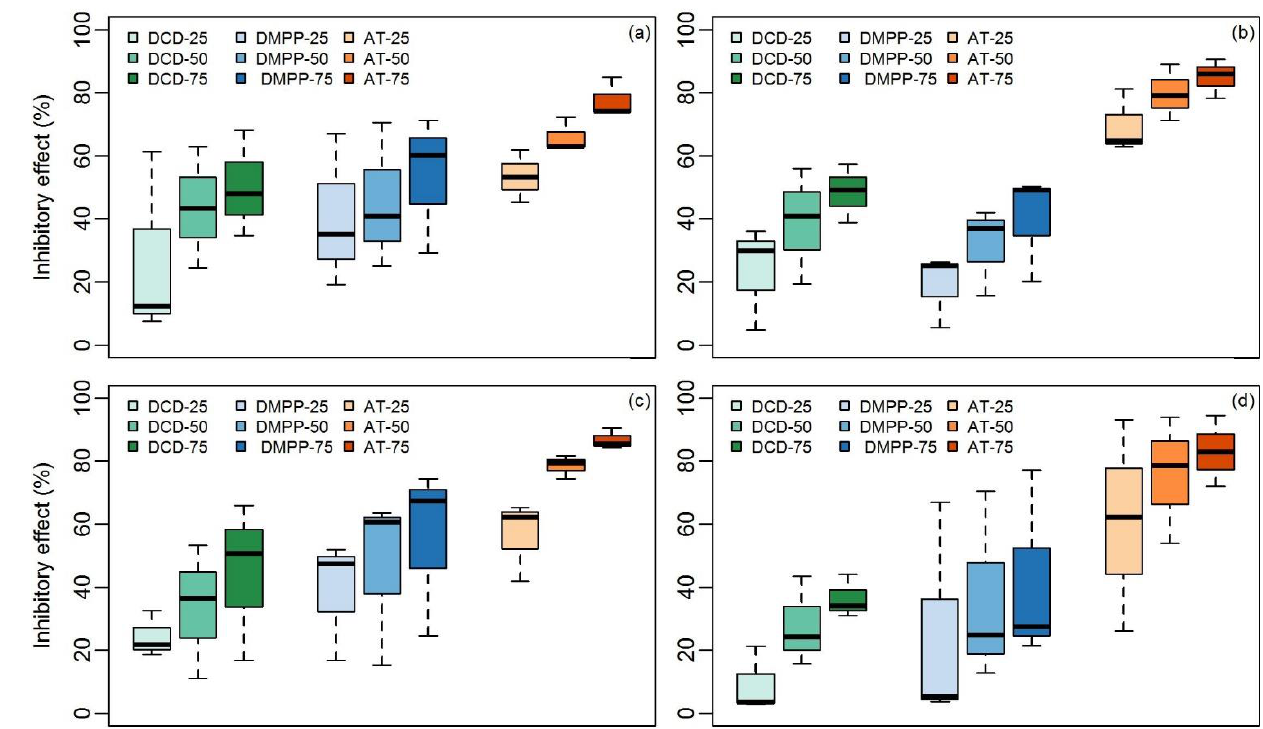
Figure 3. Boxplot of the inhibitory effect (IE) in non-croplands and croplands treated with dicyandiamide (DCD), 3,4- dimethylpyrazole phosphate (DMPP), and allylthiourea (AT) at three application rates (25 mg of NI/kg of dry soil, 50 mg of NI/kg of dry soil, and 75 mg of NI/kg of dry soil) incubated at two temperatures. ( a ) croplands, 23 °C; ( b ) non-croplands, 23 °C; ( c ) croplands, 37 °C; and ( d ) non-croplands, 37 °C.